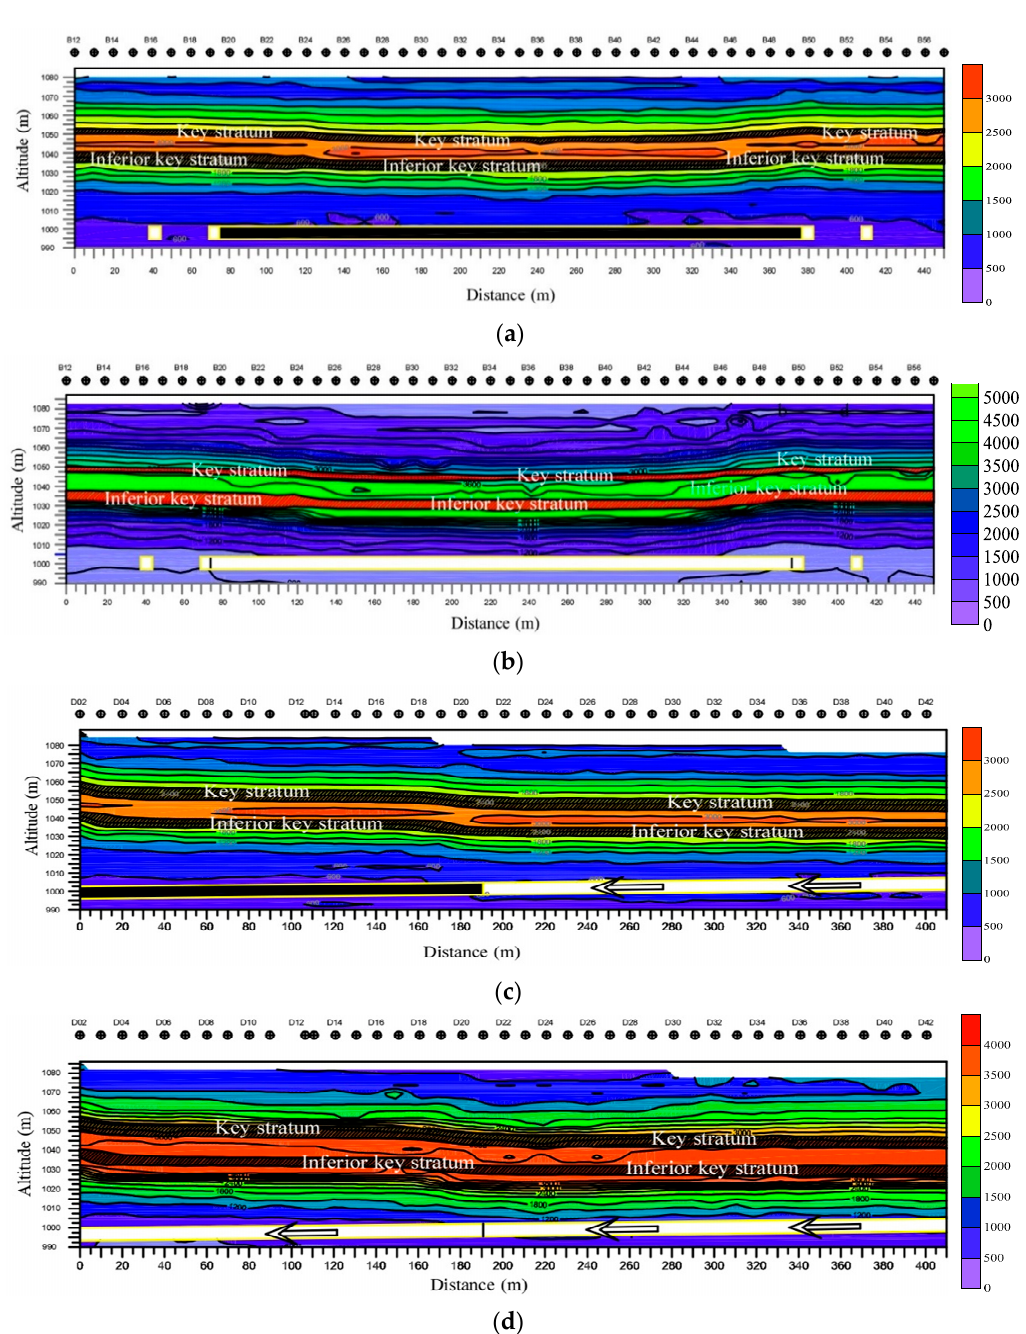
Figure 9. The AR characteristics of lines B and D: ( a ) line B before mining; ( b ) line B after mining; ( c ) line D before mining; ( d ) line D after mining.